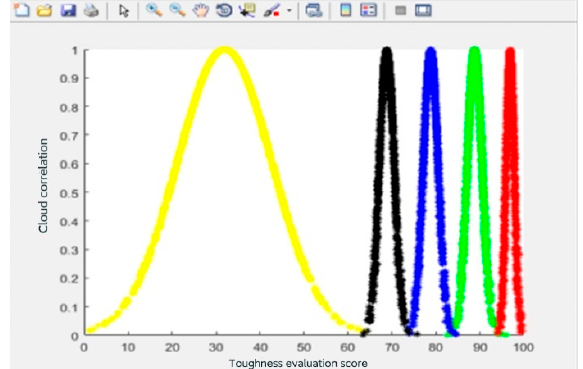
Figure 5. A C index standard cloud chart.